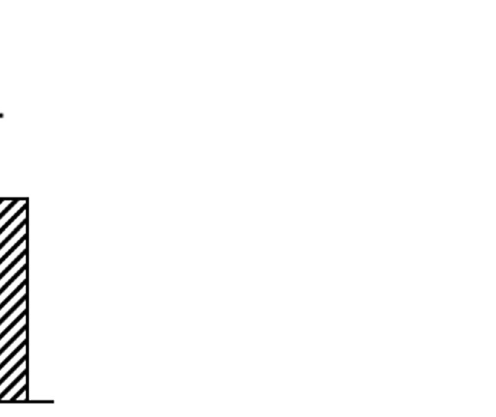
Figure 4. The effect of juice based diet on ( a ). Plasma nitric oxide and ( b ). Urinary nitric oxide. Data are mean ± SEM (n = 20). One way repeat measures ANOVA was performed. The difference to baseline is indicated *** p < 1.0E − 08 .